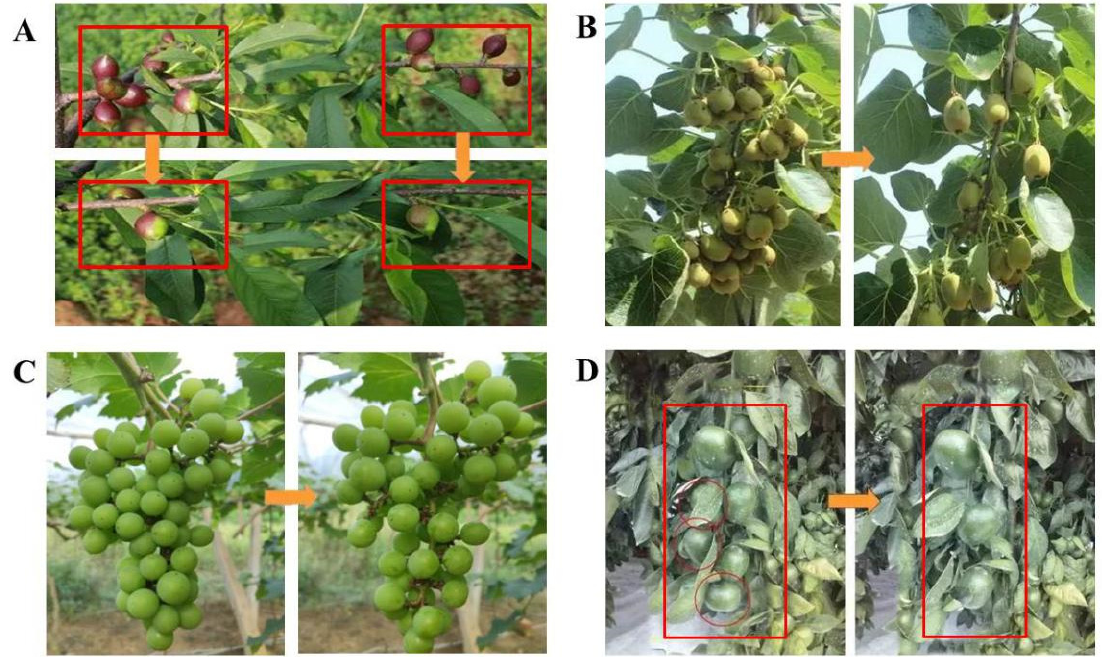
Figure 1. Thinning fruit: ( A ) peach, ( B ) kiwifruit, ( C ) grape, ( D ) and citrus. Thinning fruit improves the economic value of horticultural crops. However, the careless handling of thinned unripe fruits will cause variable harm to the soil, plants and environment. The traditional utilization of some discarded unripe fruits could reduce the toxicity of the soil environment. Some farmers use unripe thinned fruits as poultry feed [20]. In the tropics, sheep feed is generally based on corn and soybean which must be imported from abroad. Archimède de et al. [21] substituted the imported feed with local food resources and reported that unripe discarded bananas together with local forages replaced the conventional protein supplements of corn and soybean in sheep feed. Orange waste is also effective in reducing the fat content of poultry and increasing meat content [22,23]. Additionally, discarded unripe fruits may also be used together with other agricultural wastes for composting, power generation, and fuel extraction [15,24].